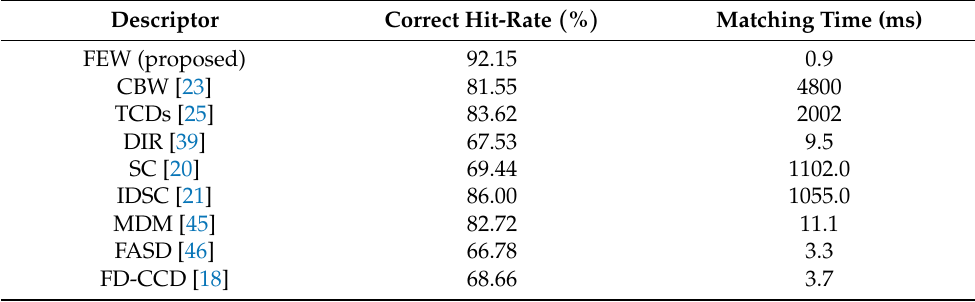
Table 5. Comparison of correct hit-rate and matching time on Kimia 99